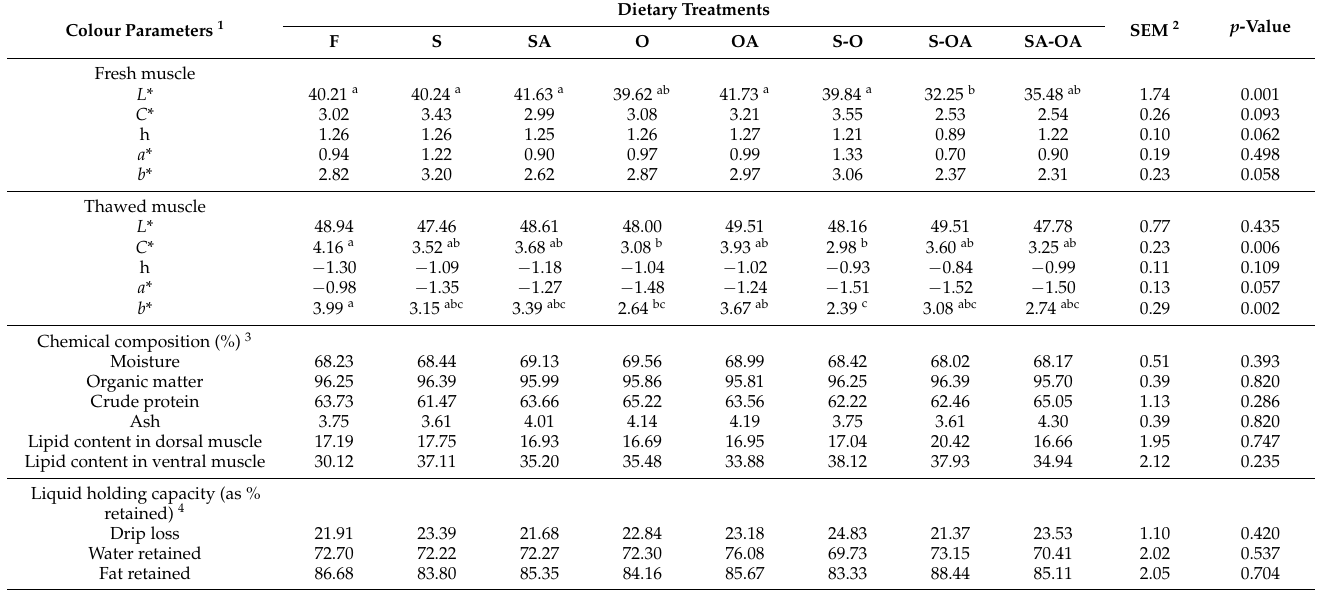
Table 6. Colorimetric assessment, chemical composition and liquid holding capacity of European seabass flesh according to different dietary